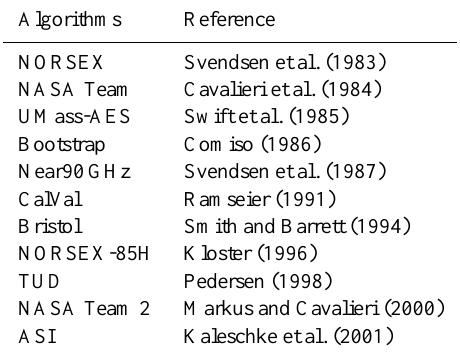
Table 2. Sea ice concentration algorithms used to calculate the in- fluence of sea ice area on estimates of sea ice thickness and volume.